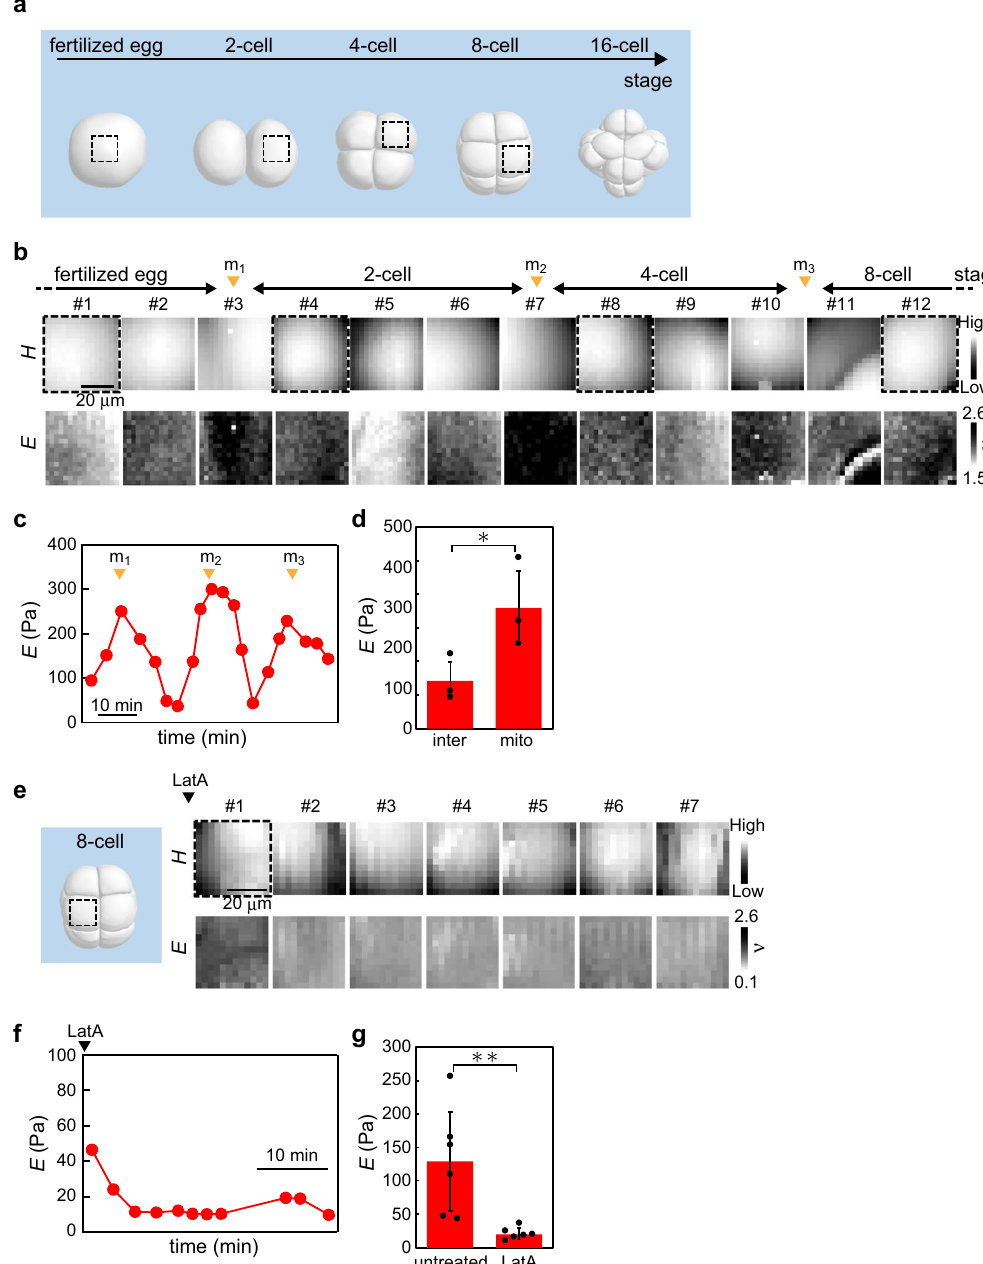
Fig. 2 Mapping the ascidian embryo in the initial symmetrical developmental stages. a Morphological change in embryonic cells of the 3D model from the fertilised egg (1-cell) to the 16-cell stage. The four dotted squares (black) represent the measured regions that approximately correspond to the four AFM images (#1, #4, #8 and #12) in b . b Portions of the H and E images of the embryo mapped at the initial symmetrical developmental stages. The cell division occurred at the times depicted by arrowheads (orange: m 1 , m 2 and m 3 ). c Plots of geometrically averaged E around the cell centre estimated from all images measured in b . d E -values of embryonic cells at the timing of cell division (mito) and in interphase (inter). Data are geometric mean ± s.d. from n = 3 embryos. * P < 0.05. e Portions of H and E images of the embryo mapped at the 8-cell stage after treatment with Latrunculin-A (LatA) as depicted by the arrowhead (black). f Plots of geometrically averaged E around the cell centre estimated from all images measured in d . g E -values of embryonic cells in untreated and LatA-treated conditions. Data are geometric mean ± s.d. from n = 6 embryos. ** P <